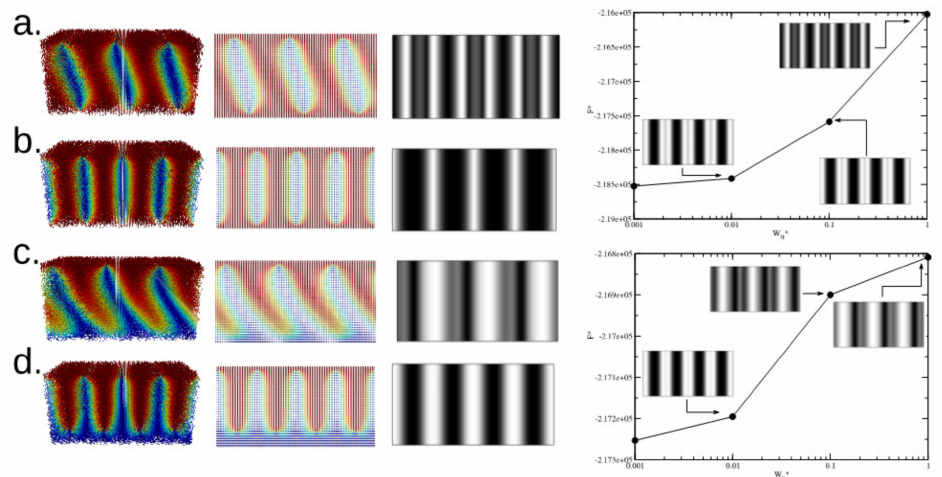
Figure 7. HH (Homeotropic anchoring on both surfaces) and HP (Homeotropic-planar anchoring) channels. (Left) Stable and metastable states under strong anchoring conditions ( a ) stable state in an HH-channel, ( b ) metastable state in an HH-channel, ( c ) stable state HP-channel, and ( d ) metastable state in a HP-channel. (Right) Free energy as a function of the anchoring energy for HH and HP channels with channel thickness h = p